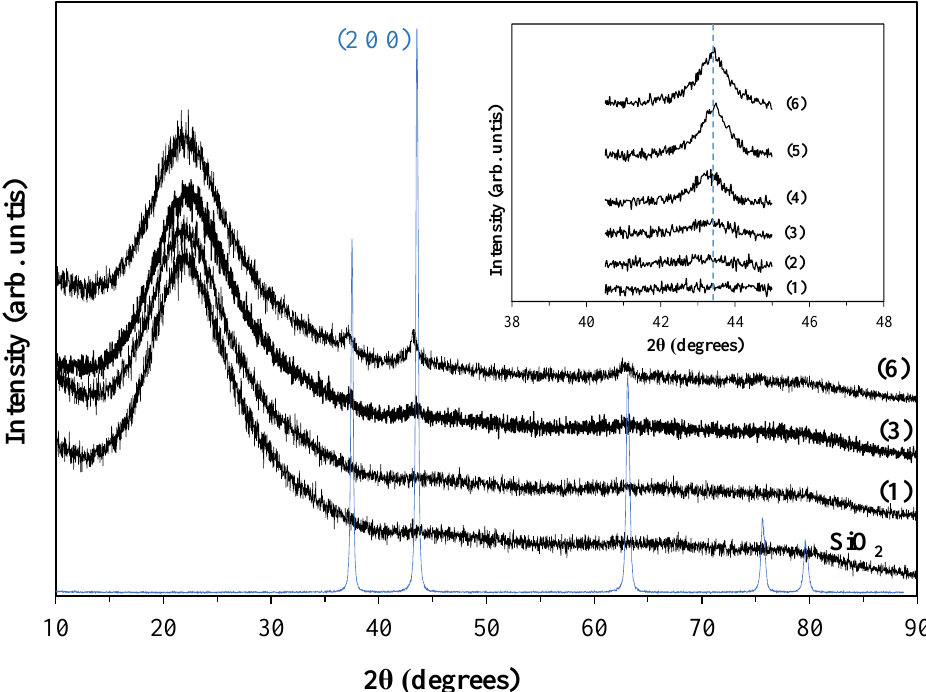
Figure 1. PXRD patterns of SiO 2 -CH-Ni-oc- X samples, prepared via impregnation of SiO 2 with Ni octanoate solution diluted in cyclohexane (see experimental section); X : ( 1 ) 1000 ppm Ni, ( 2 ) 2500 ppm Ni, ( 3 ) 5000 ppm Ni, ( 4 ) 10,000 ppm Ni, ( 5 ) 15,000 ppm Ni, and ( 6 ) 20,000 ppm Ni. The dashed line in the inset graph represents the (2 0 0) reflection of NiO (bunsenite). The pattern of pure NiO (bunsenite structure) is also shown for comparison (blue pattern).